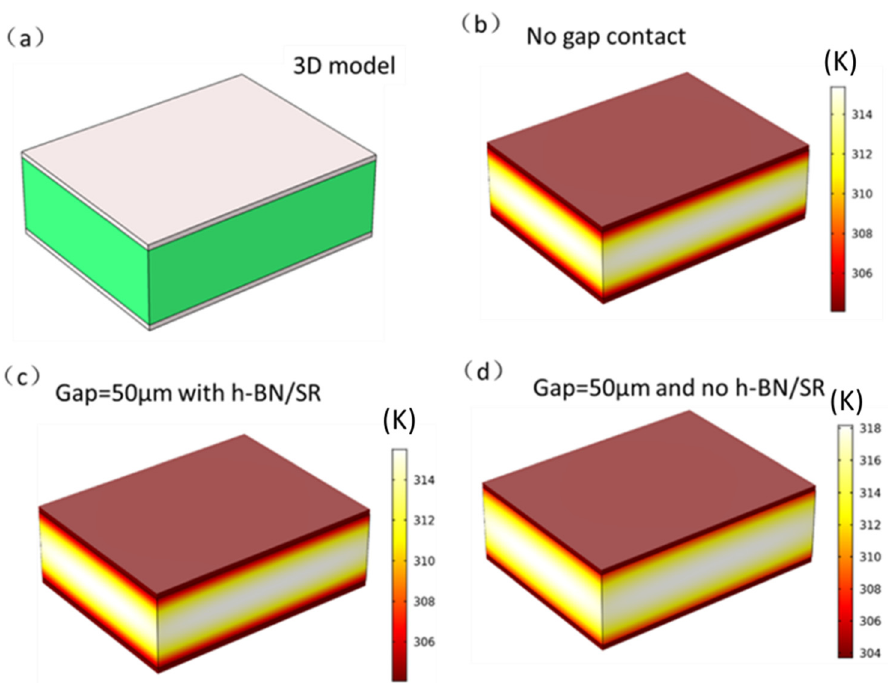
Figure 13. ( a ) 3D model of the battery and liquid-cooling aluminum plate, ( b – d ) temperature cloud charts of the battery and liquid-cooled aluminum plate under battery discharge of 4C, corresponding to ideal contact without gap, with gap contact (50 µ m), and without SR filling (50 µ m), respectively.